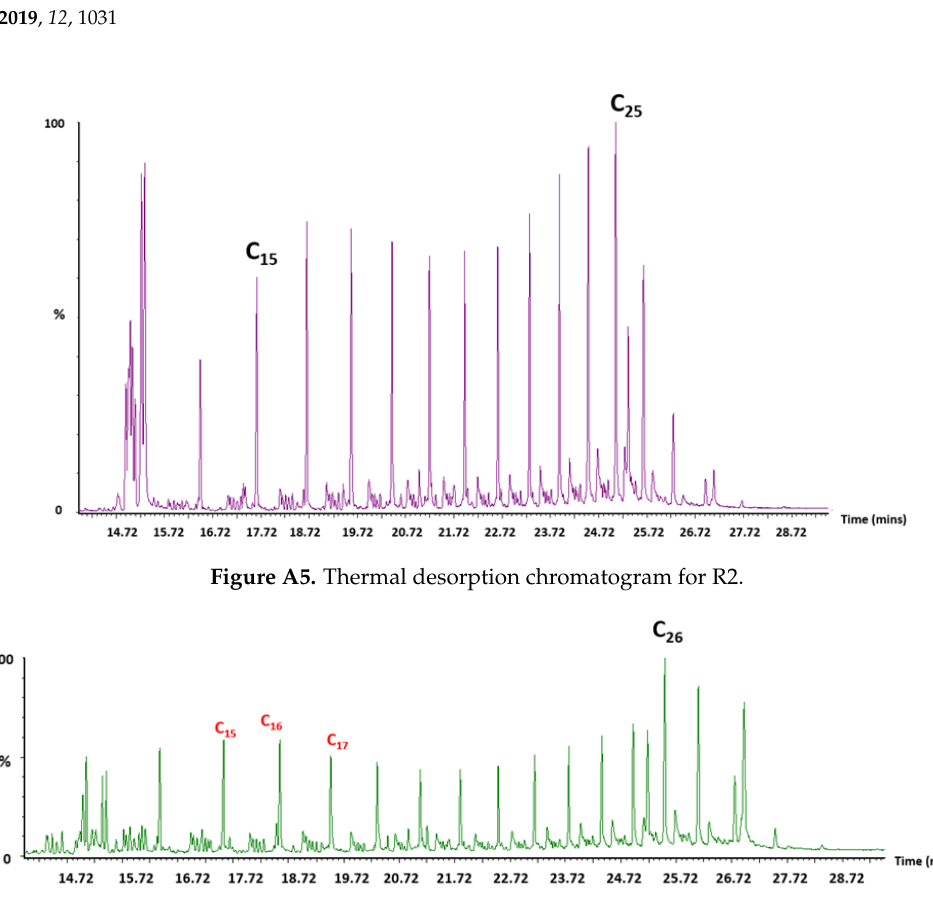
Figure A6. Thermal desorption chromatogram for R3.